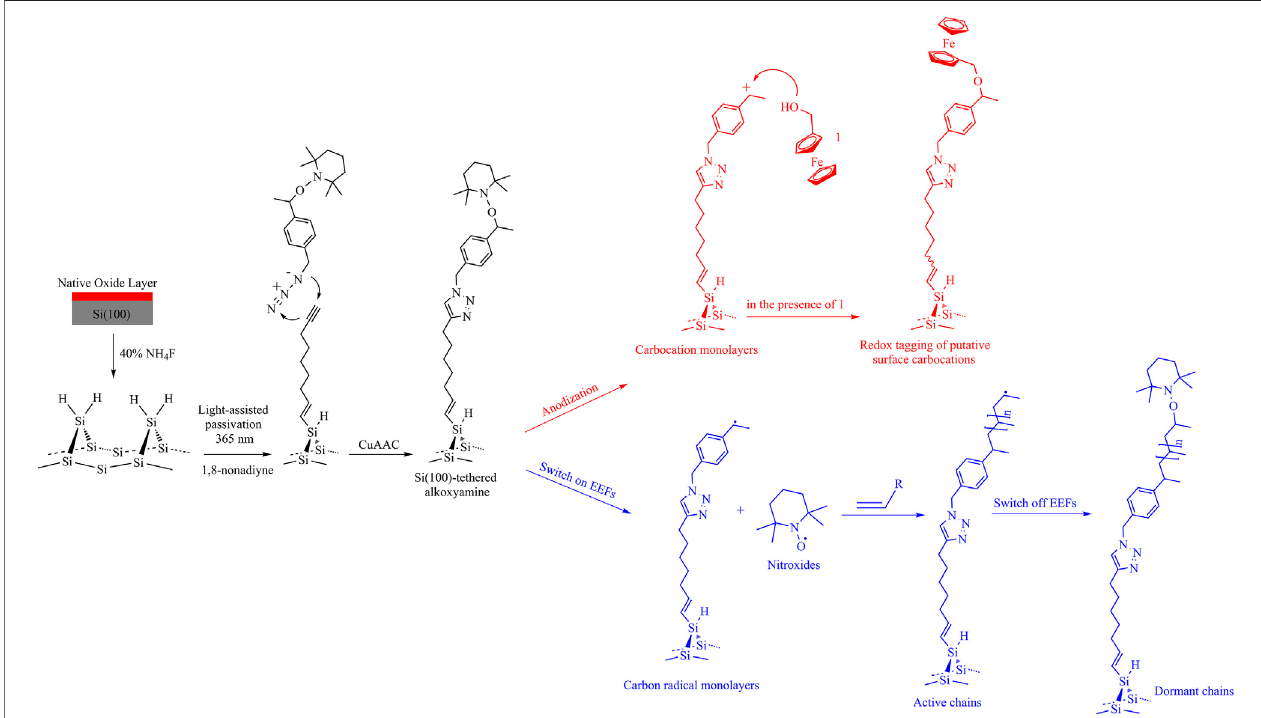
FIGURE2| Light-assisted(365 nm)hydrosilylationof1,8-nonadiynetopassivateaSi(100)-Hsurfaceandcovalentattachmentofalkoxyamines via “ click ” reactions to yield an alkoxyamine monolayer. (Red route) Anodization of the alkoxyamine monolayer in the presence of the nucleophile ferrocenemethanol leads to release of TEMPOdiffusedintheelectrolyteandformationofaredox-taggedmonolayerbythereactionbetweenferrocenemethanolandtheputativesurface-tetheredcarbocation monolayer. (Blue route) External electric fi elds (EEFs) triggered decomposition of alkoxyamines to generate active carbon-centered radical monolayers for initiating the living radical polymerization. The polymerized process can be terminated by recombining the diffusive TEMPO while switching off EEFs.